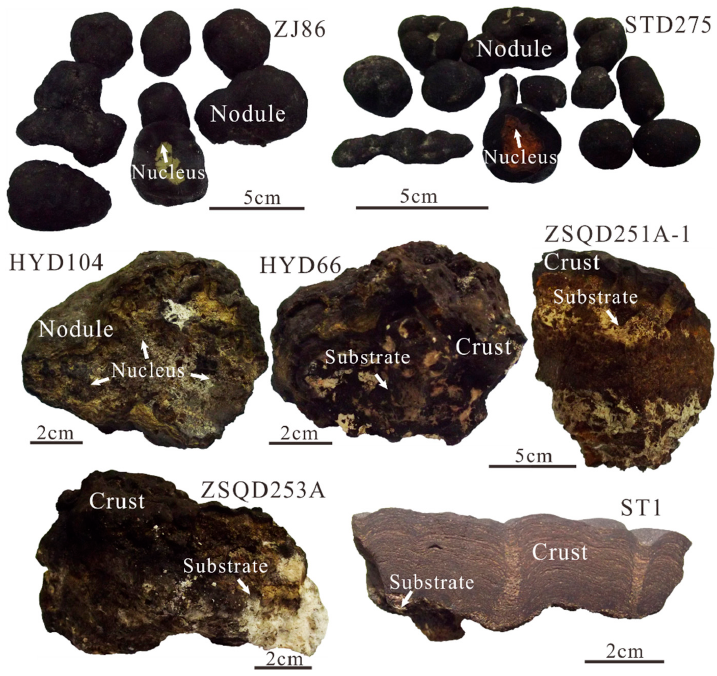
Figure 2. Sample photos of the SCS crusts and nodules analyzed.